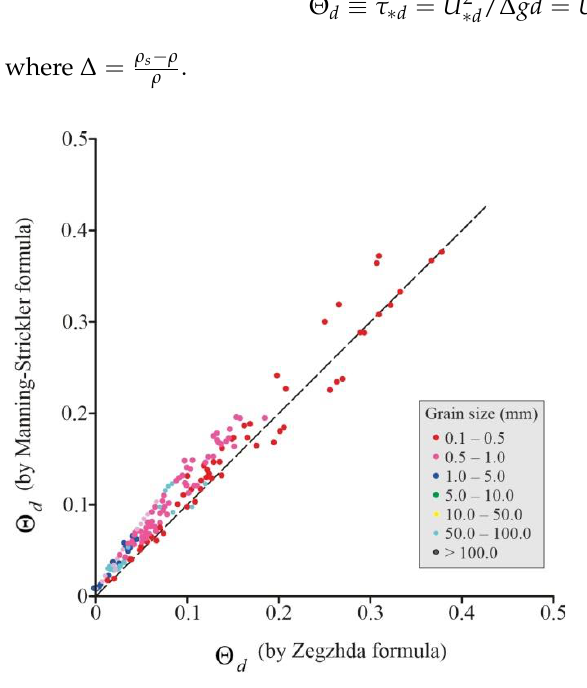
Figure 2. Comparison of the results of calculation of sediment mobility coefficient Θ d parameter by the formulas of Manning – Strickler and Zegzhda.